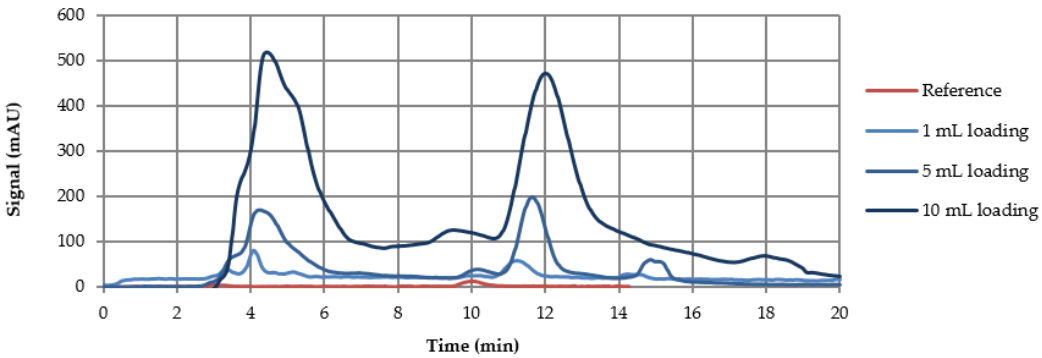
Figure 10. Artemisinin reference and different loading volumes of the extraction sample on the LiChroPrep self-packed column at 254 nm.